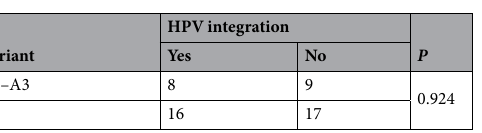
Table 3. Association between HPV16 A variants and HPV16